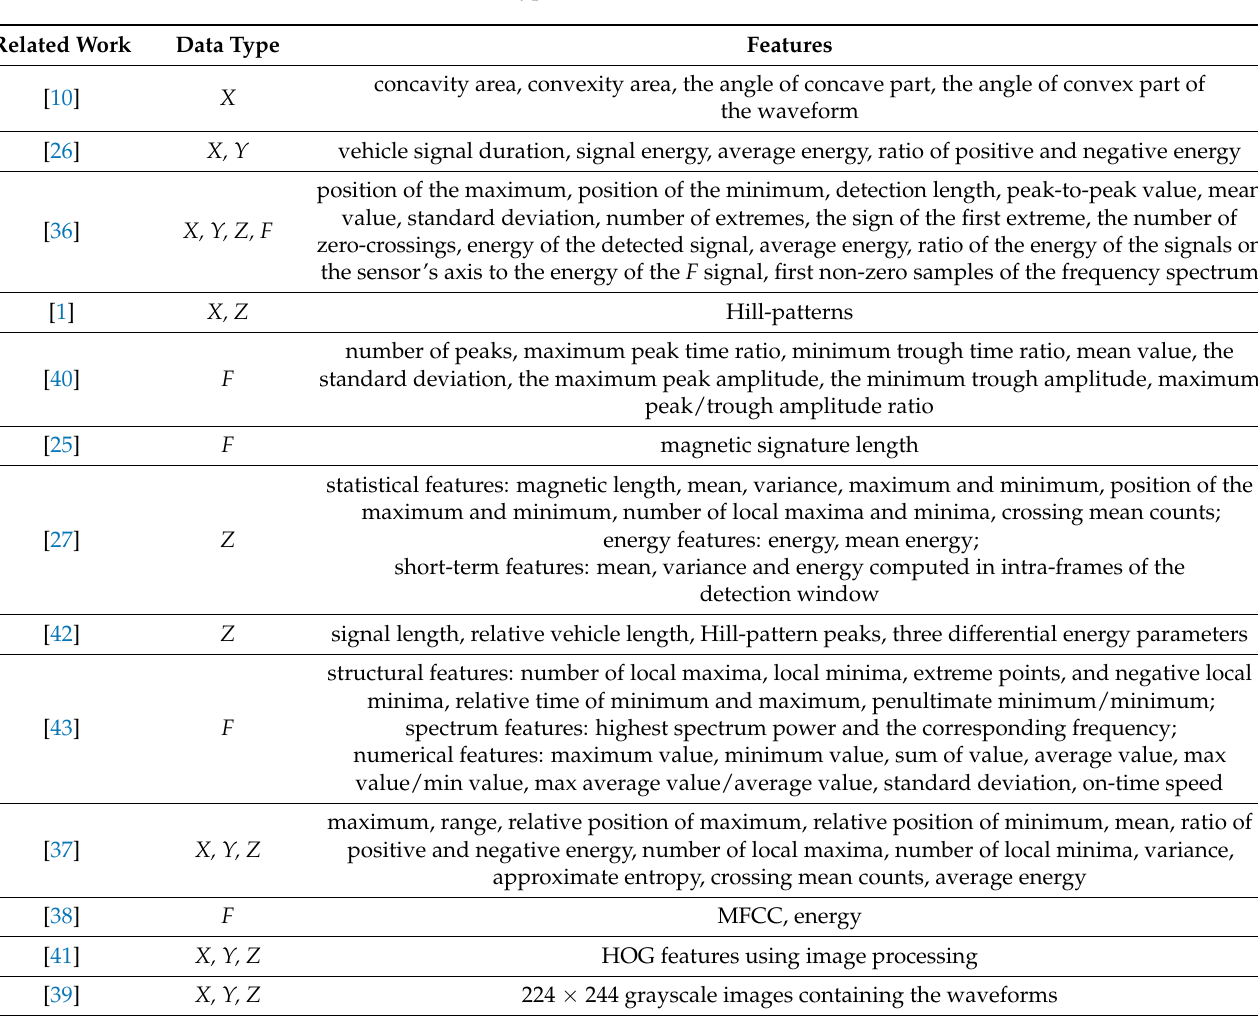
Table 2. Used feature types in related